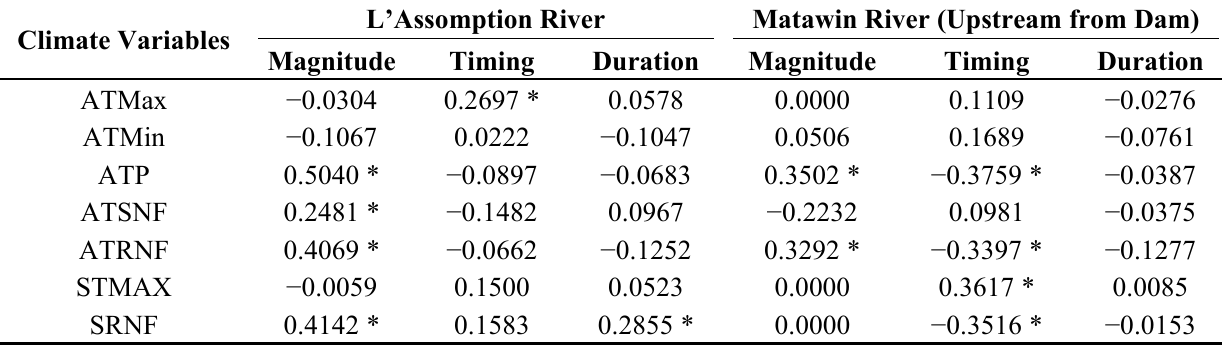
Table 6. Coefficients of correlation between characteristics of annual daily minimum flows and climate variables in natural settings